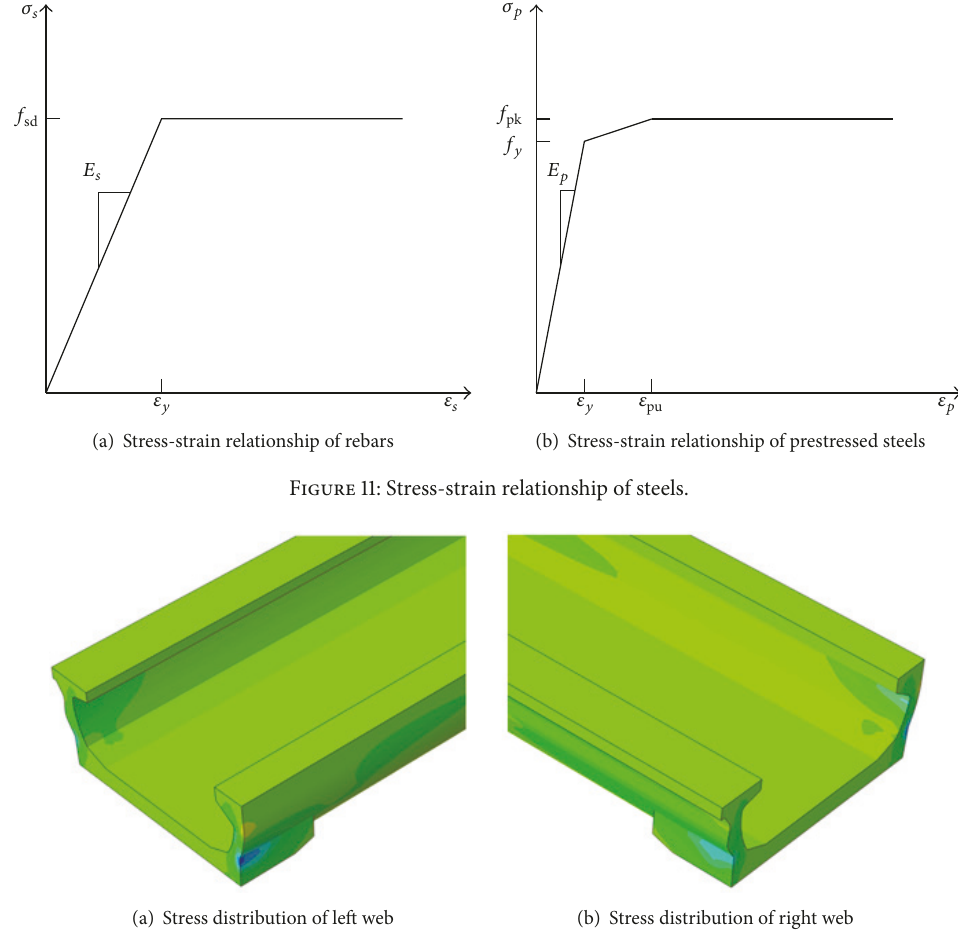
Figure 12: Stress contours at the end of U-shaped girder before tensioning with original design. The range of the tension stress over 3.3MPa